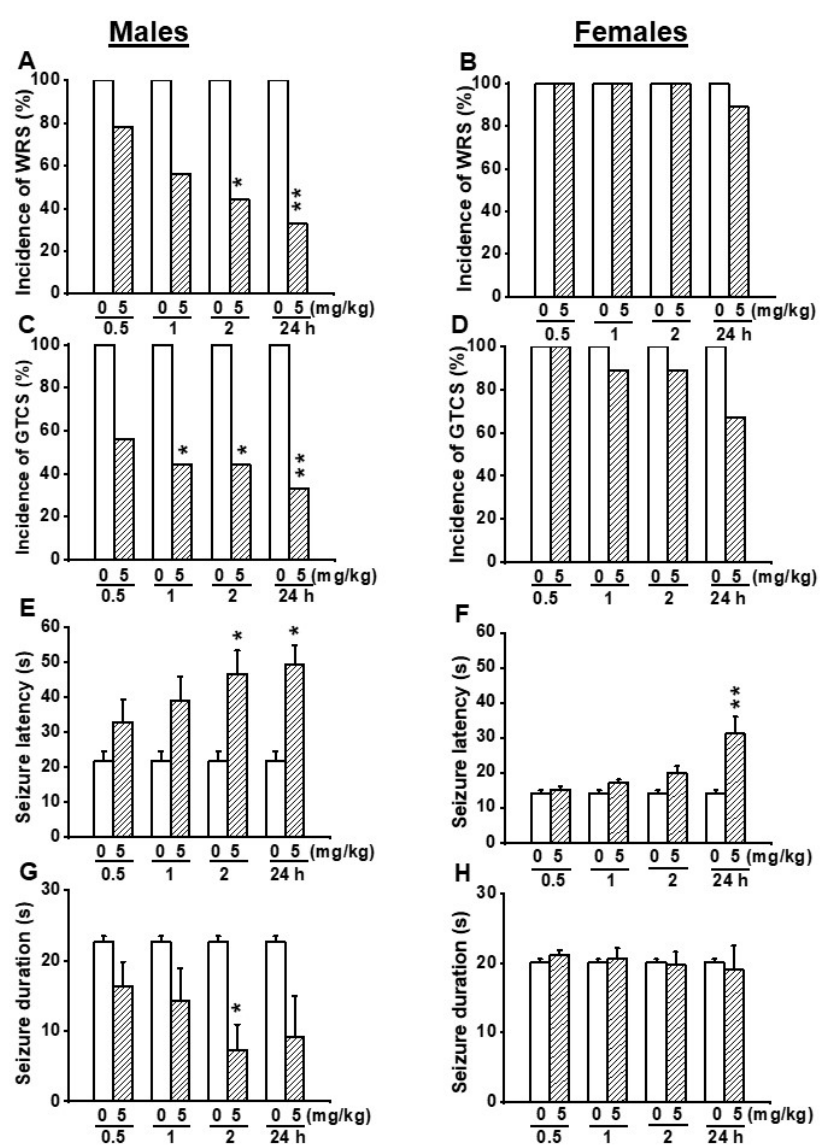
Figure 3. Effects of acute EACT treatment at the dose of 5 mg/kg on acoustically evoked seizures. The effects EACT, a potent activator of TMEM16A, were evaluated at different post-treatment time points of 0.5, 1, 2, and 24 h in adult male ( n = 9) and female ( n = 9) GEPR-3s. ( A ) EACT treatment significantly reduced the incidence of the occurrence of WRSs at 2 and 24 h post-treatment time points in males. ( B ) EACT treatment did not considerably reduce the incidence of the occurrence of WRSs in females. ( C ) EACT treatment significantly reduced the incidence of the occurrence of GTCSs at 1, 2, and 24 h post-treatment time points in males. ( D ) EACT treatment did not considerably reduce the incidence of the occurrence of GTCSs in females. ( E ) EACT treatment significantly delayed the seizure onset at 2 and 24 h post-treatment time points in males. ( F ) In females. EACT treatment also significantly delayed the seizure onset at the 24 h post-treatment time point. ( G ) EACT treatment significantly reduced the seizure duration at the 2 h post-treatment time point in males. ( H ) EACT treatment did not alter the seizure duration in females. Data from the incidence of the occurrence of WRSs and GTCSs were represented as a mean percentage (%), and Fisher Exact test was used for analysis. Data from the seizure latency and seizure duration were presented as mean ± S.E.M., and one-way ANOVA followed by Bonferroni correction was used for analysis. Opened and filled bar graphs represent control-treated (pre-EACT) and EACT treated GEPR-3s, respectively. * p < 0.05, ** p <